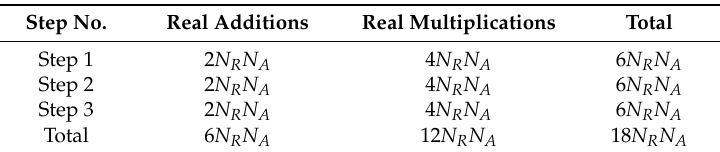
Table 2. Computational burden of complex multiplications in different